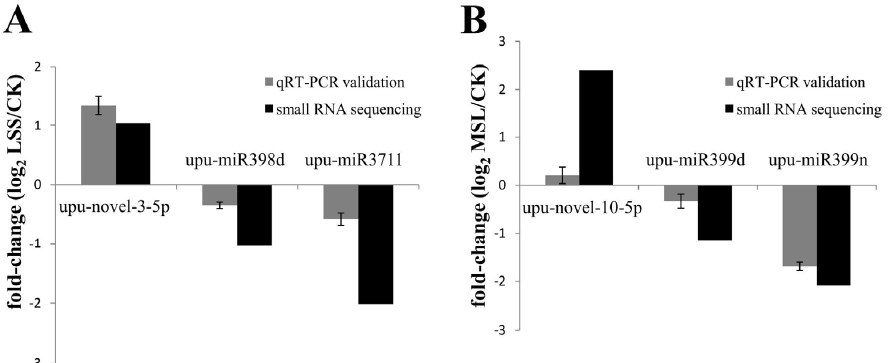
Figure 4. qRT ‐ PCR validation of differentially expressed miRNAs in Ulmus pumila L. roots under salt stress. ( A ) Relative expression analysis of miRNAs by qRT ‐ PCR analysis and high ‐ throughput sequencing between LSS (light salt stress for a short time) and CK (without salt stress) libraries; ( B ) Relative expression analysis of miRNAs by qRT ‐ PCR analysis and high ‐ throughput sequencing between MSL (medium ‐ heavy salt stress for a long time) and CK libraries. Error bars indicate standard deviations.